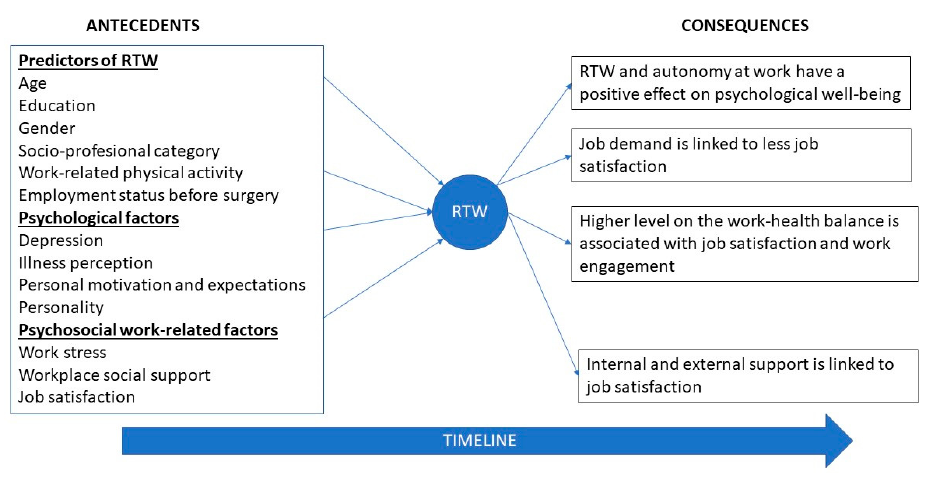
Figure 3. Main findings of the review.